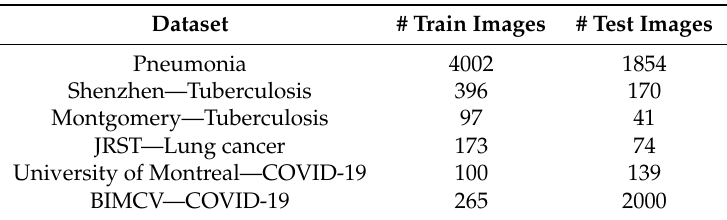
Table 11. Hold-out validation dataset.